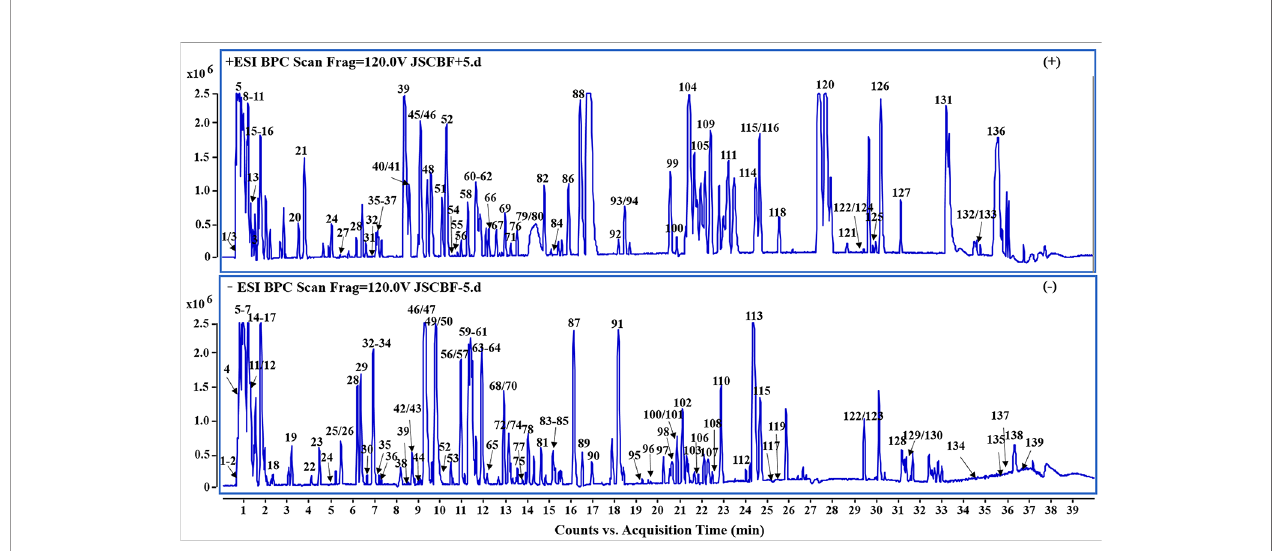
FIGURE 2 | Representative base peak chromatogram (BPC) of Jiang-Suan-Chu-Bi recipe (JSCBR) in the positive and negative ions mode,